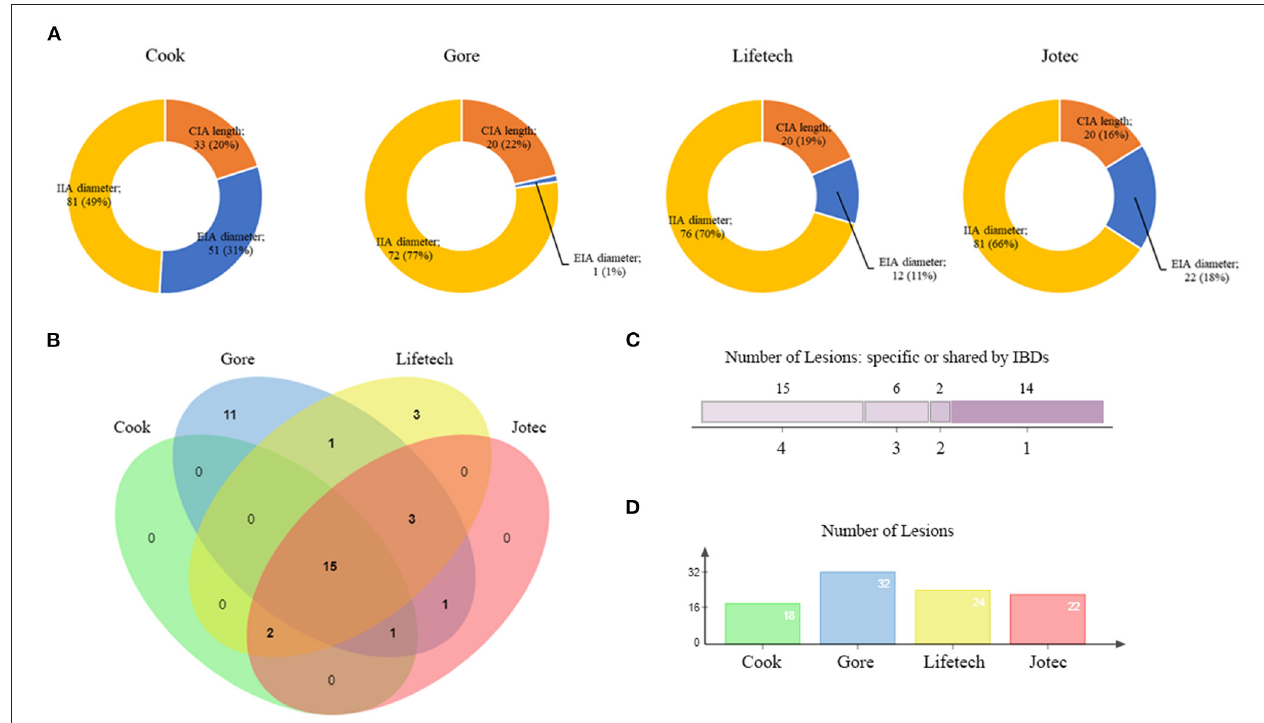
FIGURE 3 | Overview of IBD applicability. (A) The proportion of exclusion reasons for four IBDs. (B) A four-set Venn diagram showing the numbers of lesions meeting the criteria of IBDs. (C) The number of lesions meeting different IBD criteria. (D) The number of lesions included by each device. IBD, iliac branch